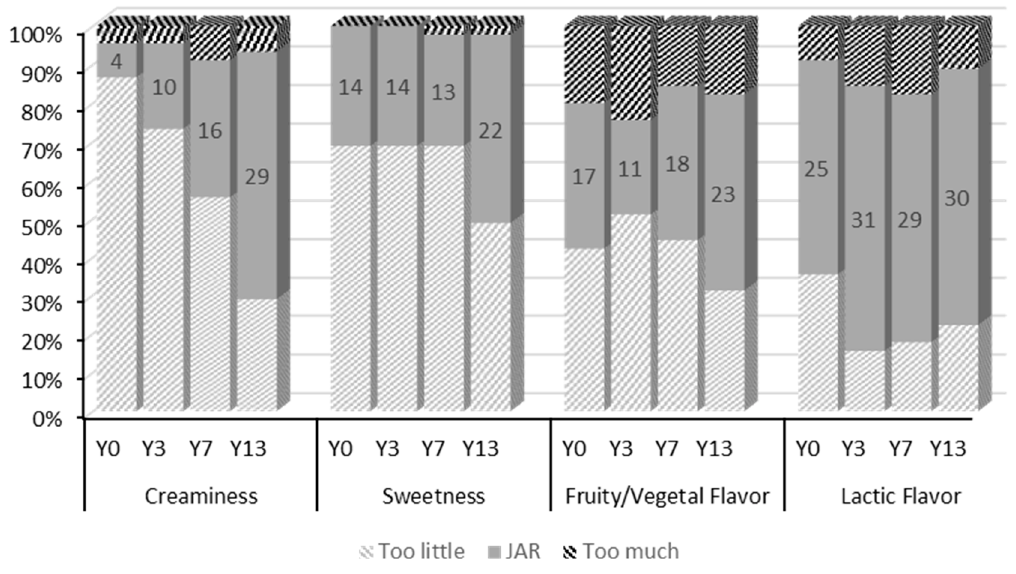
Figure 2. Frequency distribution in percentage of consumer responses for Just-About-Right scores for each dimension (Too little, JAR, Too much) and each attribute. The number of consumers out of the total ( n = 45) that rated an attribute as “Just About Right” is indicated in each column.